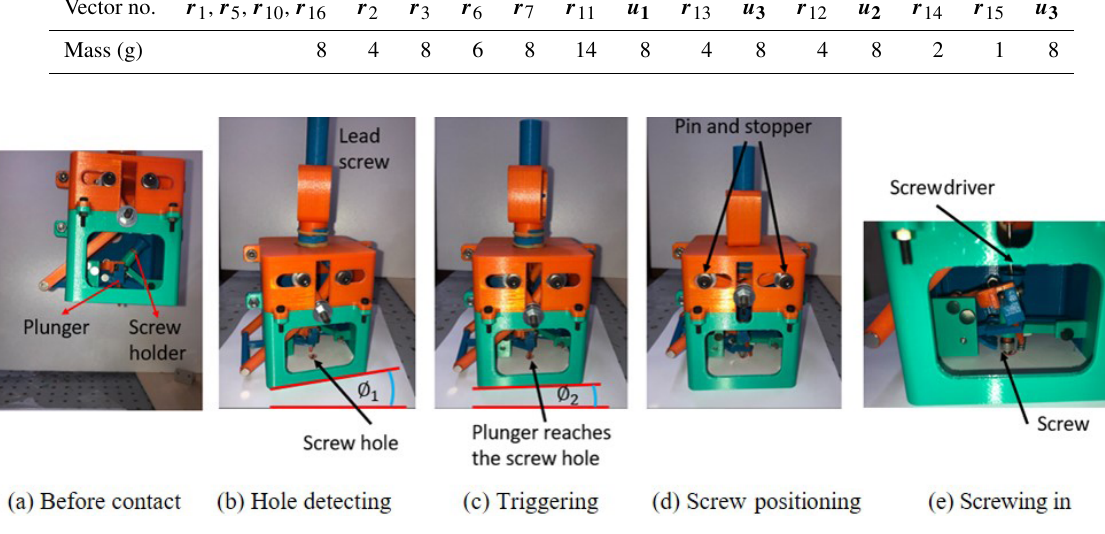
Figure 12. Prototype